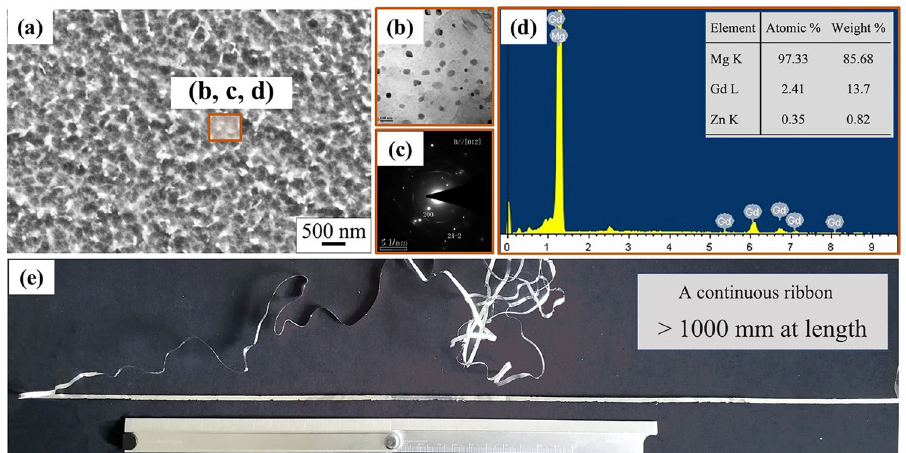
Figure 2. The RS Mg–15Gd–1Zn ribbon: ( a) the SEM image showing very fine grains; ( b , c) the bright-field TEM image and the corresponding selected area electron diffraction (SAED) pattern; ( d) the EDS analysis of SSSS Mg matrix; ( e) the microstructure of the RS